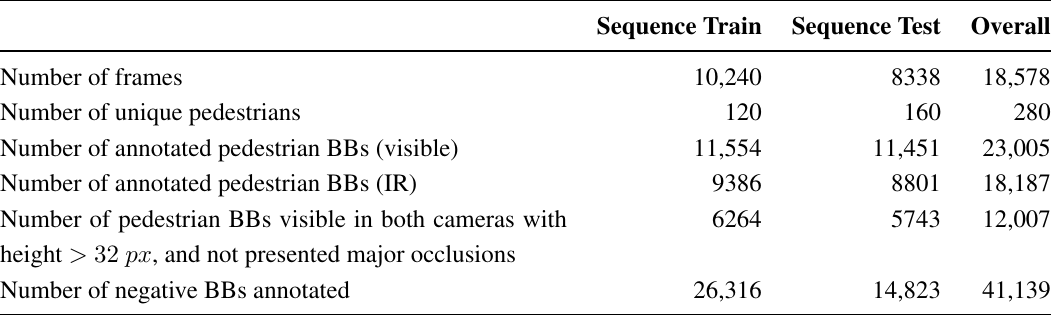
Table 2. Parma-Tetravision dataset